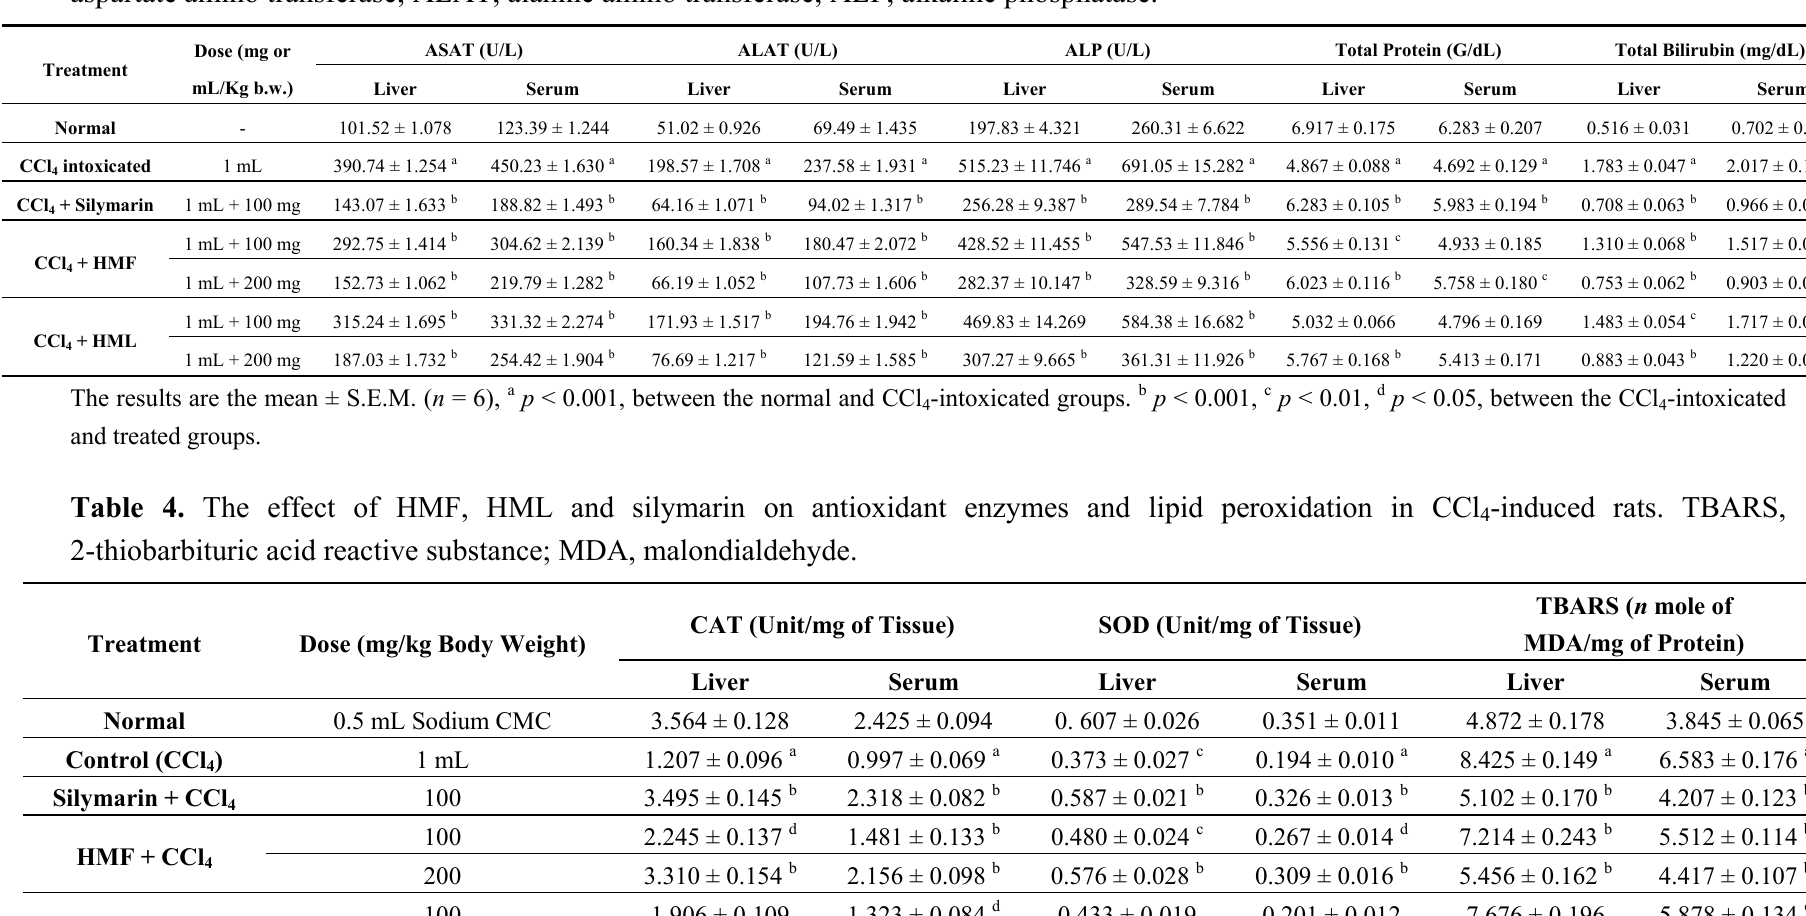
-intoxicated rats. ASAT, 4